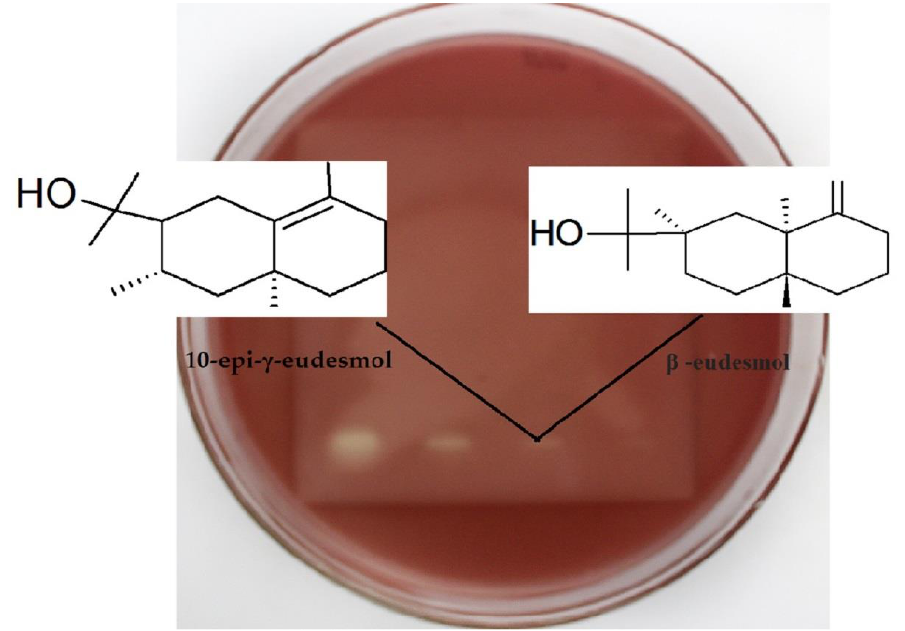
Figure 2. Antimicrobial bioautography against Escherichia coli , Gram-negative bacteria.